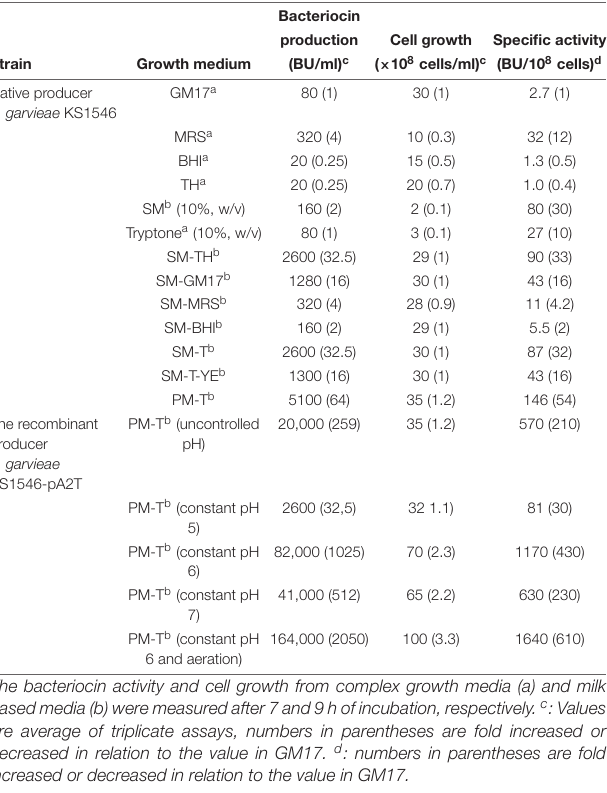
TABLE 2 | Influence of growth media, increased gene dose and culture conditions on bacteriocin production.